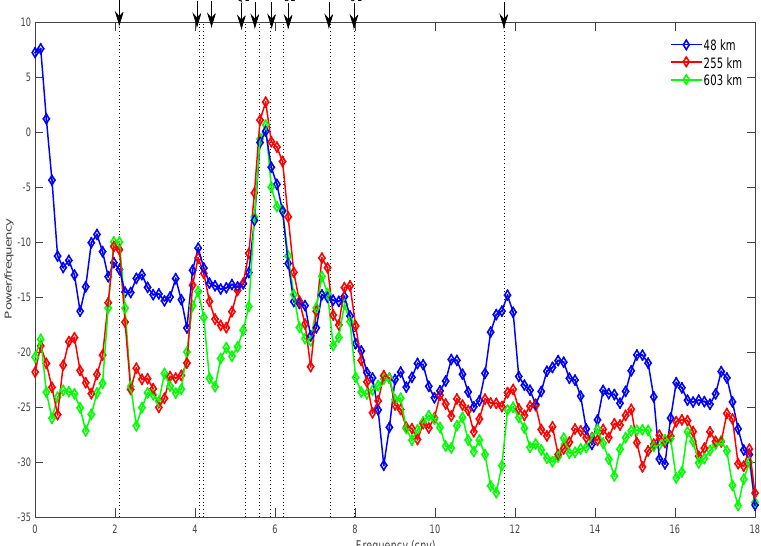
Figure 4. Power spectral density (PSD) of observed sea level anomaly (SLA) along TOPEX-Jason ground track 38. Points are located at 122°7 ′ 54.84 ″ E, 17°45 ′ 42.84 ″ S (blue curve), 121°25 ′ 53.04 ″ E, 16°0 ′ 50.40 ″ S (red curve), and 120°17 ′ 60.00 ″ E, 13°5 ′ 38.40 ″ S (green curve), around 48 km, 255 km, and 603 km, respectively, from the coast. The aliasing period of the eight main tidal constituents (e.g., M 2 ) and major shallow-water tidal constituent (M 4 ) are shown by arrows.